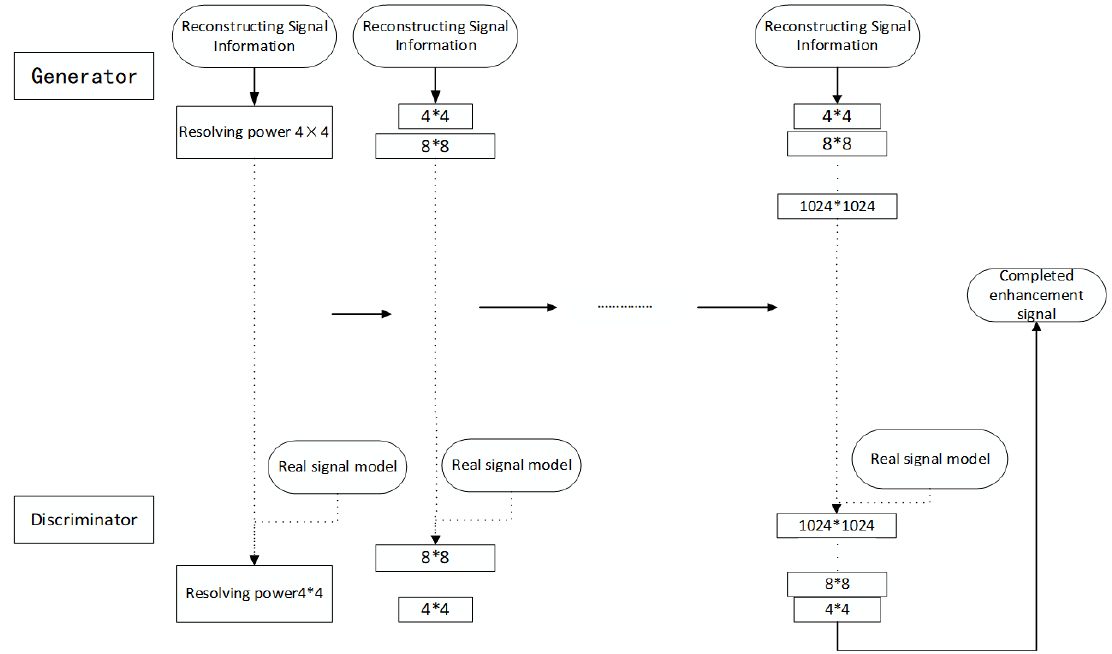
Figure 5. The flow chart of generative adversarial networks (GAN) enhancement.